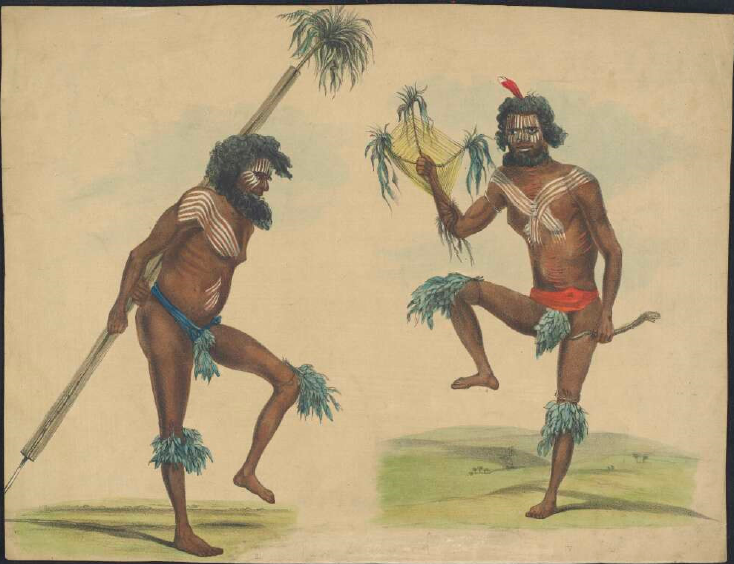
Figure 2. B. Waterhouse Hawkins (lithographer), George French Angus, (illustrator), T. McLean publisher, Portraits of the Aboriginal inhabitants and their various dances , 1847 lithograph, 53.2 cm × 35.8 cm, image courtesy National Library of Australia Canberra. nla.obj-135637177-1. 4